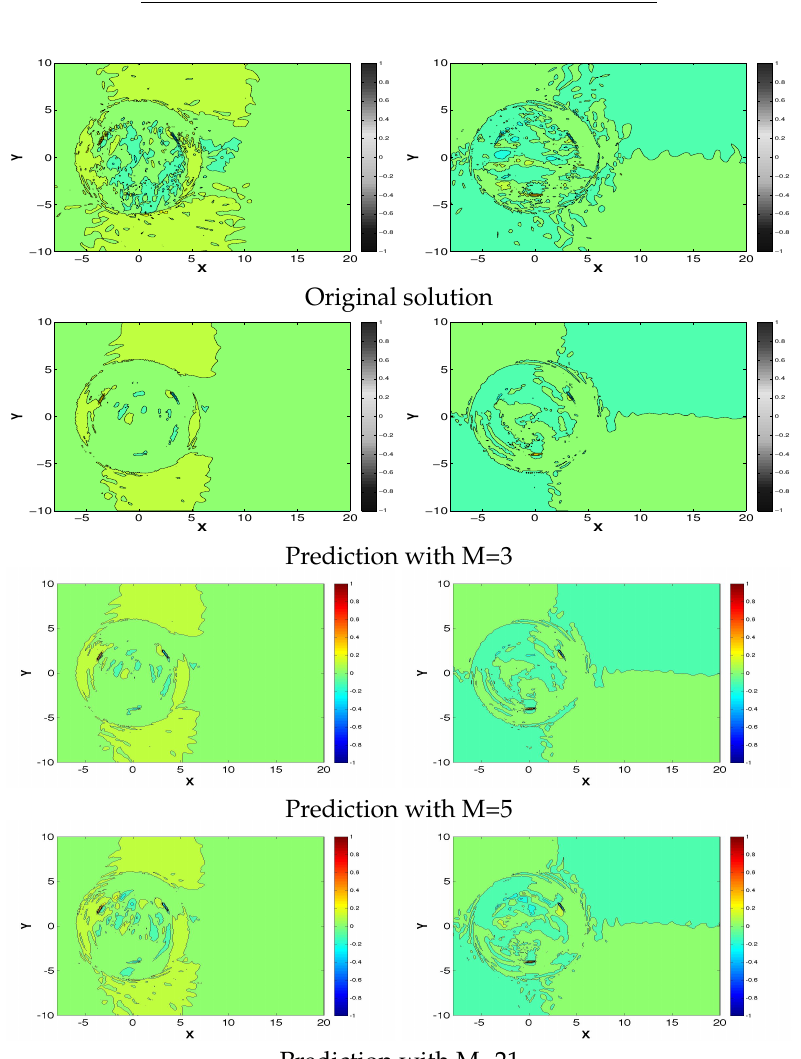
Figure 15. Counterpart of Figure 6 in the three-blades turbine applying HODMD in 145 snapshots starting at time 25.604